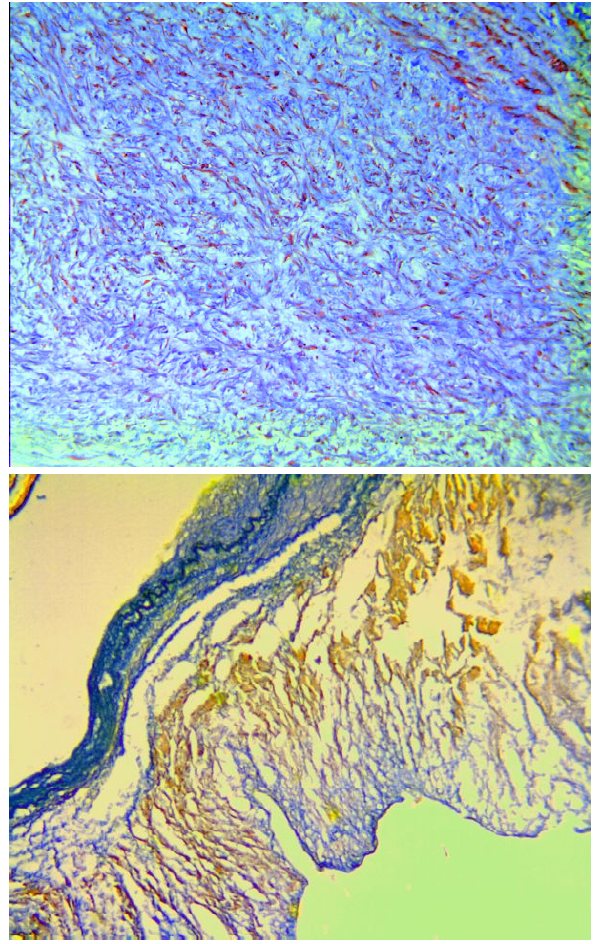
Fig. 2 – Marfan’s aortic tissues showing cystic medial necrosis with (A) smooth muscle cell fragmentation and more collagen deposition, Masson×200; and (B) proliferation and disruption of the intima (blue), and smooth muscle cell fragmentation (yellow) and collagen deposition (red) in the media. VG-Victoria blue bichrome staining×100